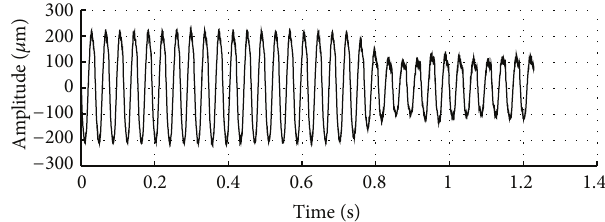
Figure 18: The rotor protection by elastic support/dry friction damper when blade-out event